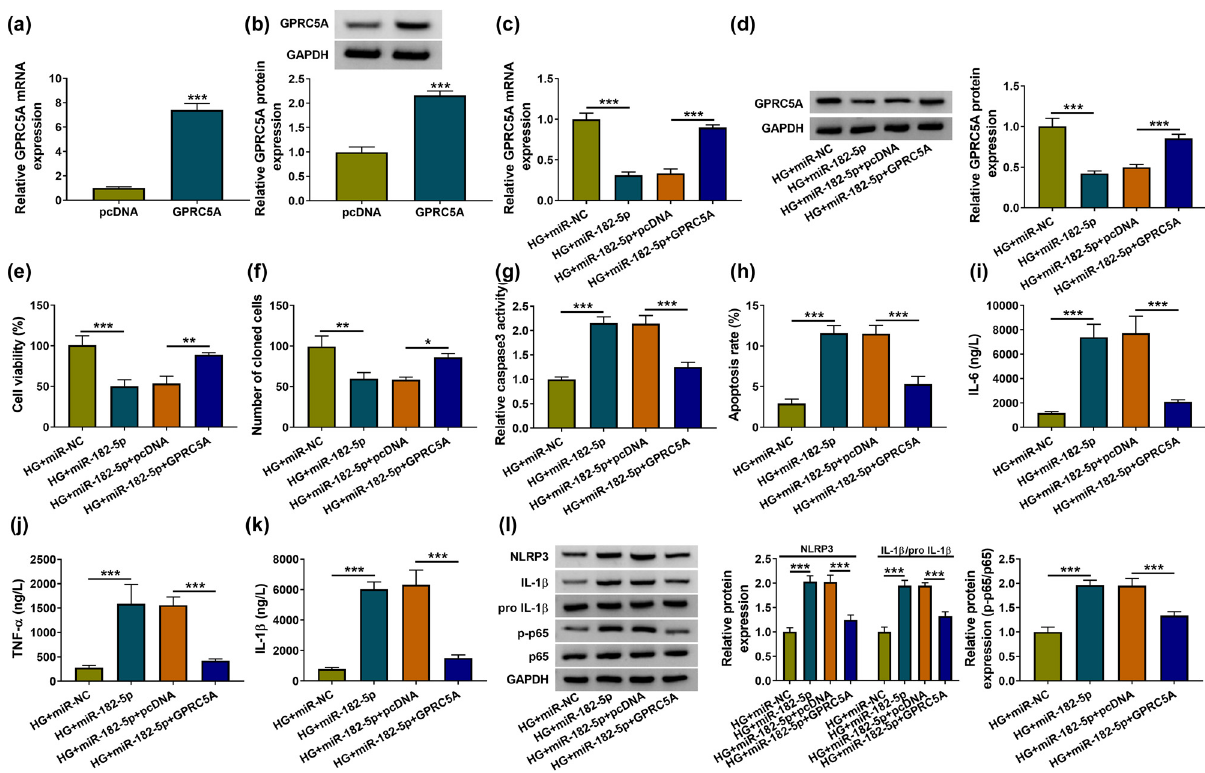
Figure 6: GPRC5A upregulation suppressed the miR - 182 - 5p - mediated cell damages and NF - κ B signal in HG - treated HK - 2 cells. ( a and b ) The e ffi ciency of GPRC5A vector was analyzed via RT - qPCR and western blot. ( c and d ) After HK - 2 cells were treated with HG + miR - 182 - 5p, HG + miR - 182 - 5p + GPRC5A, or the relative controls, the RT - qPCR and western blot were conducted to examine the GPRC5A expression. ( e – k ) CCK - 8 for cell viability ( e ) , colony formation assay for clonal ability ( f ) , caspase - 3 assay/ fl ow cytometry for cell apoptosis ( g and h ) and ELISA for in fl ammation ( i – k ) were used for the assessment of the di ff erent transfections on biological processes. ( l ) Western blot was administrated to determine the protein levels related to in fl ammation and NF - κ B pathway. * P < 0.05, ** P < 0.01, *** P <